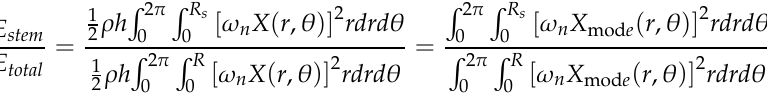
Figure 4. The frequency responses in air and vacuum for the 2nd and 4th WGMs of the 37 μ m-radius resonator ( a , b ) as well as for the 5th and 7th WGMs of the 18 μ m-radius resonator ( c , d ). Despite the fact that the anchor loss and SFD are negligible in vacuum, the Q values of the high- order WGMs are not as high as expected. There could be some other loss sources that limit the Q enhancements of high-order WGMs. The TED and AKE, which could be more significant at higher frequencies, should be taken into account.